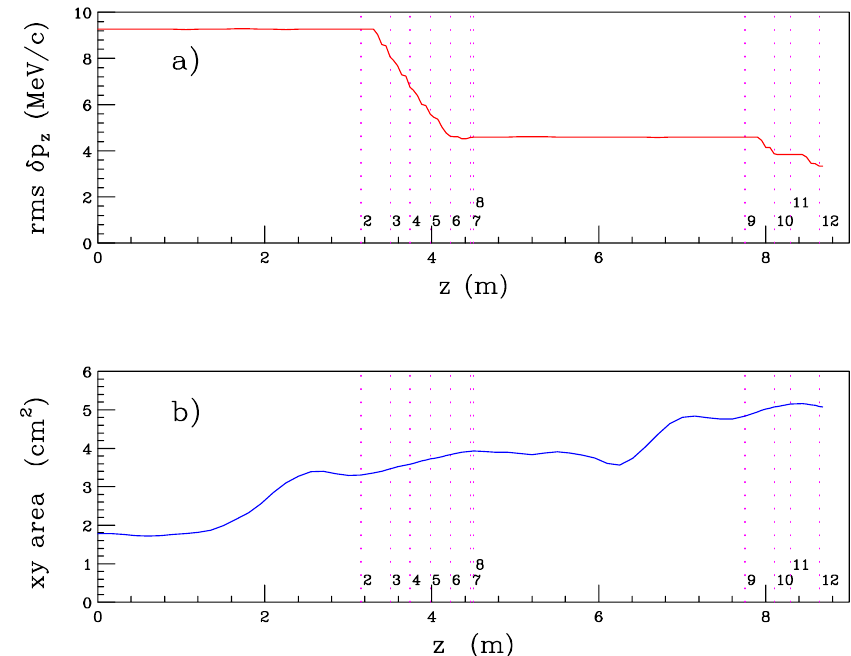
FIG. 31. (Color) (a) rms longitudinal d p z with respect to the reference momentum and (b) transverse beam area, both as a function of z .